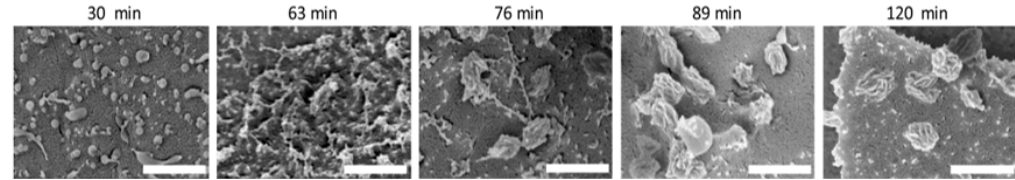
Figure 3. Time-dependent evolution of aggregate structures, 1 wt% aqueous dispersion of poly( N - n -propylglycine) 70 - block -polysarcosine 23 at 48 °C ( T > T cp ). Cryo-SEM images of the thermally annealed dispersion at different time (scale bars = 500nm). Reprinted with permission from [54] . Copyright 2016, American Chemical Society.